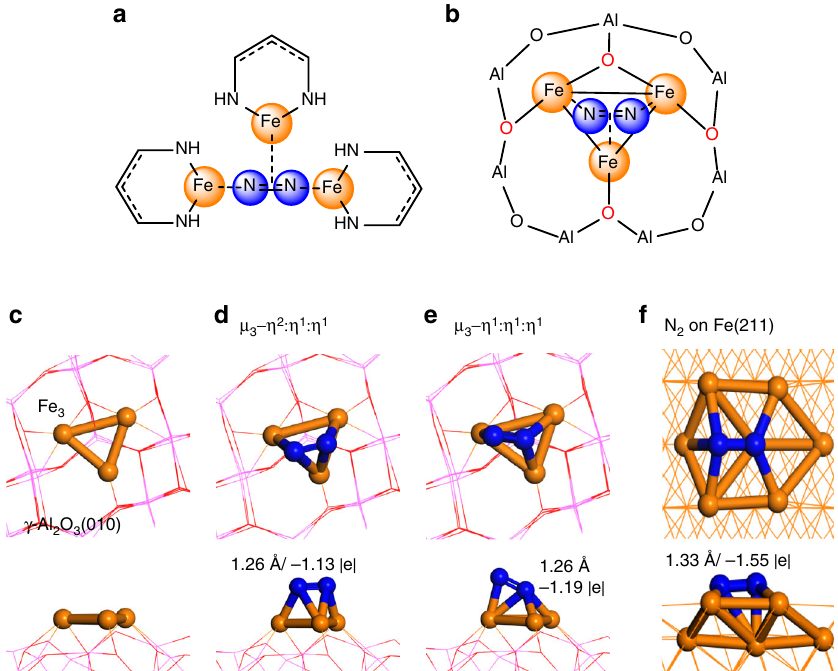
Fig. 1 Homogeneous and heterogeneous Fe 3 cluster with N 2 adsorption. a Schematic representation of N 2 coordinated with three Fe(I)-ion homogeneous complexes in the side-on/end-on/end-on ( μ 3 − η 2 : η 1 η 1 ) con fi guration; b schematic representation of N 2 coordinated with heterogeneous Fe 3 / θ -Al 2 O 3 (010) in the same con fi guration; c optimized Fe 3 cluster on θ -Al 2 O 3 (010); d , e optimized con fi gurations of N 2 adsorption on Fe 3 / θ -Al 2 O 3 (010); f N 2 adsorption con fi guration on the C7 site of Fe(211)